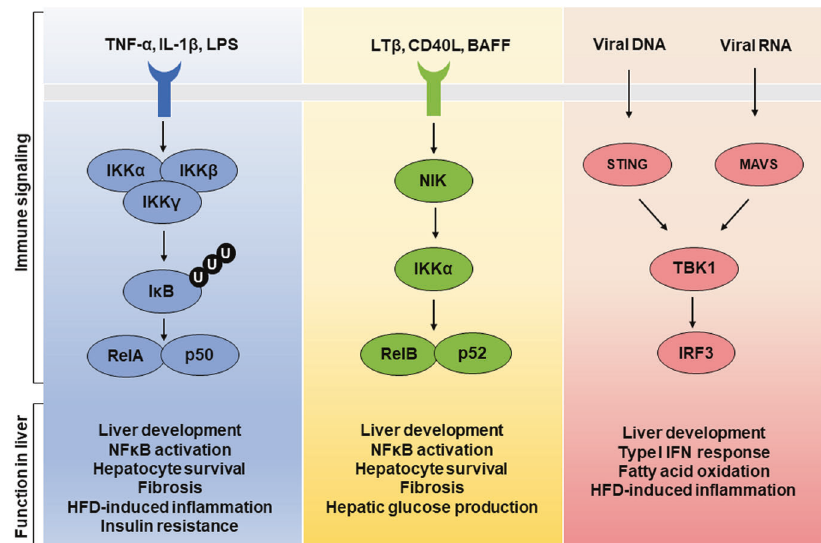
Fig. 3 IKK and TBK1 functions in the liver. Canonical NF- κ B signaling is mediated by the IKK α /IKK β /IKK γ complex upon proin fl ammatory cytokine (TNF- α or IL-1 β ) or lipopolysaccharide stimulus. This complex induces the phosphorylation-mediated degradation of I κ B, which leads to NF- κ B activation. Furthermore, LT β , CD40L, and BAFF stimulate NIK phosphorylation, thereby promoting IKK α phosphorylation and downstream signaling via the RelB:p52 complex. On the other hand, TBK1 is phosphorylated via STING or MAVS activation upon viral infection, which promotes IRF3 activation for the type I IFN response. Additionally, inactive TBK1 promotes FA oxidation in